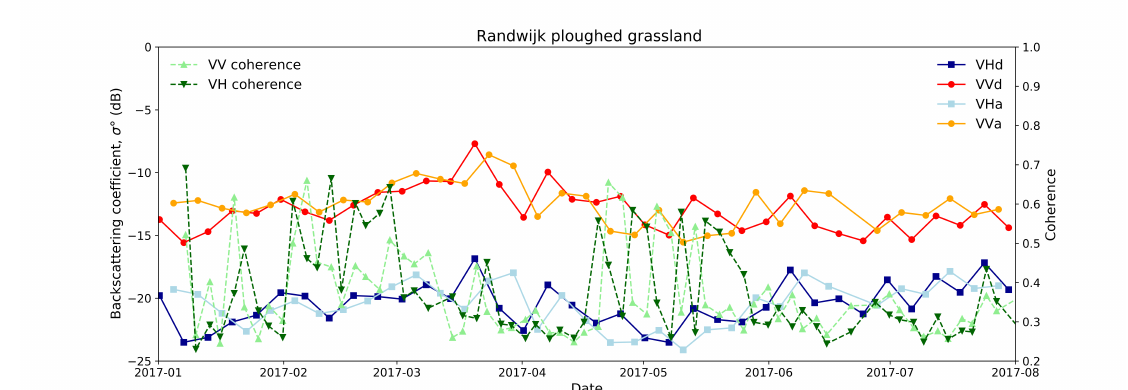
Figure 4. S1 backscattering and coherence signal for a parcel declared as permanent grassland and marked with S1.